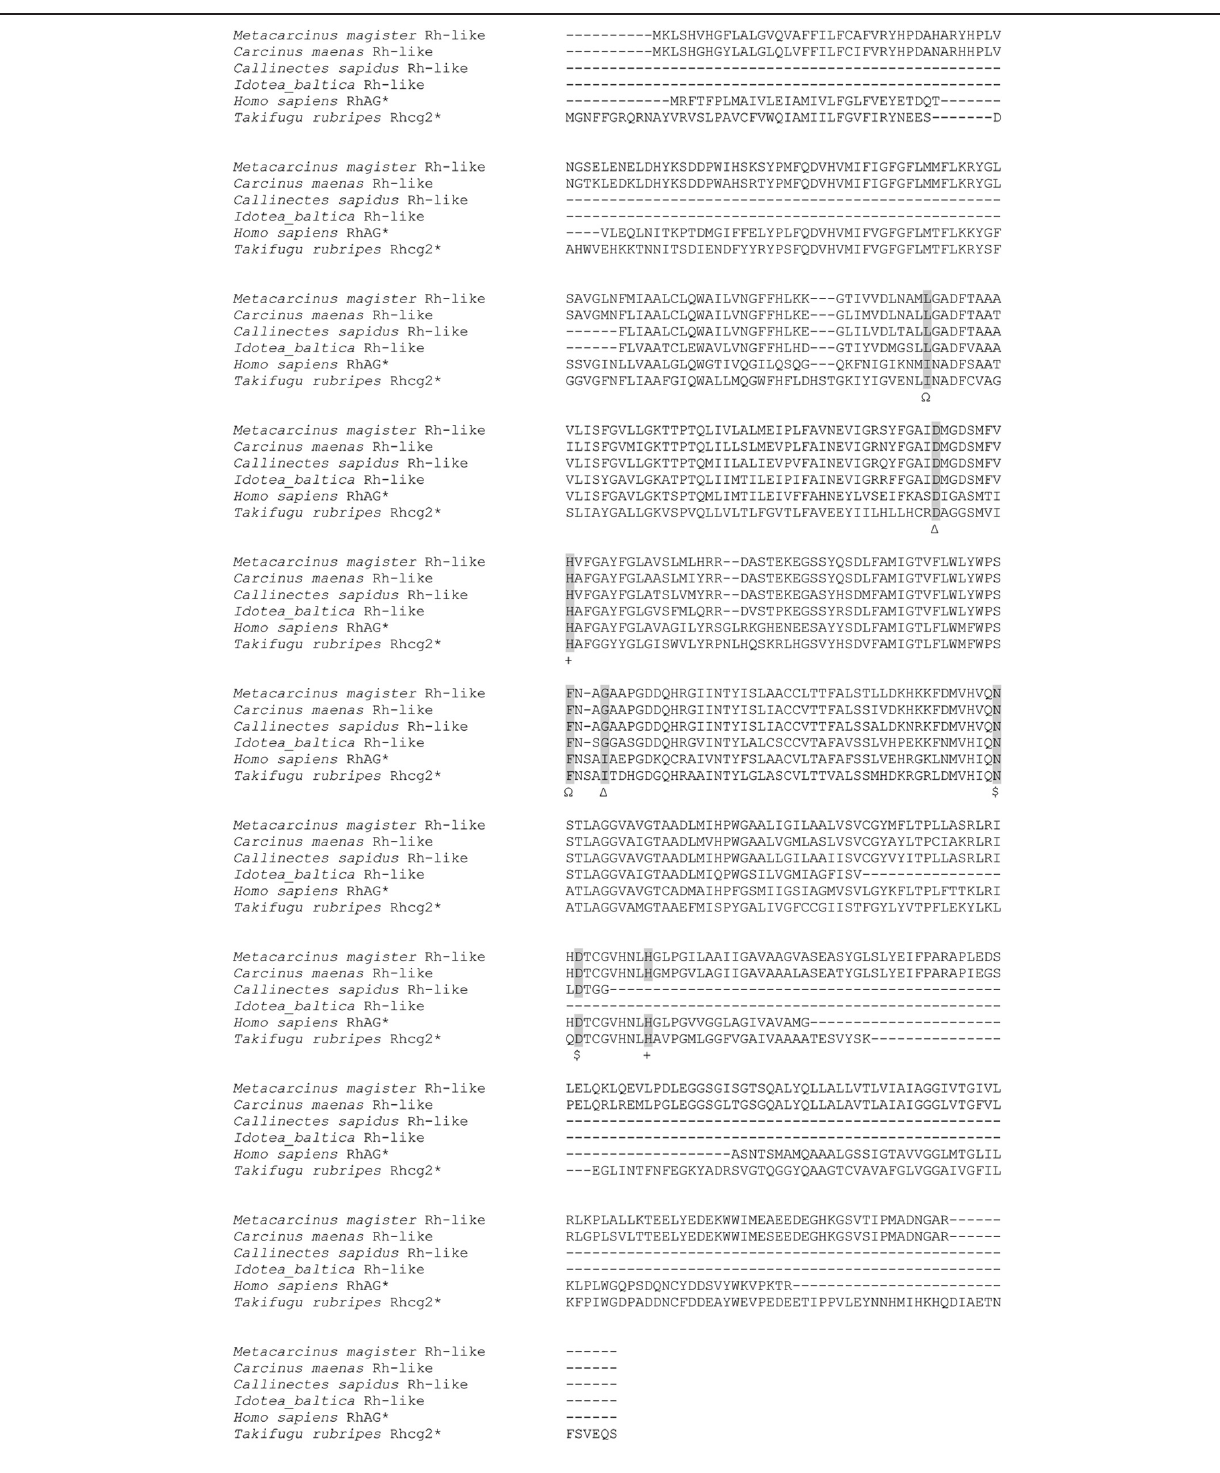
ammonia-conducting residues in the internal vestibule (Khademi et al., 2004; Zidi-Yahiaoui et al., 2009; Wu et al., 2010). GenBank accession numbers are given in brackets behind the species name. Callinectes sapidus (AAM21147), Carcinus maenas (AAK50057), Homo sapiens RhAG (NP_000315), Idotea baltica (AY094181), Metacarcinus magister (AEA41159), and Takifugu rubripes Rhcg2 (AB218982). Asterisks indicate Rh-proteins with verified ammonia transport capabilities (Marini et al., 2000; Nawata et al.,